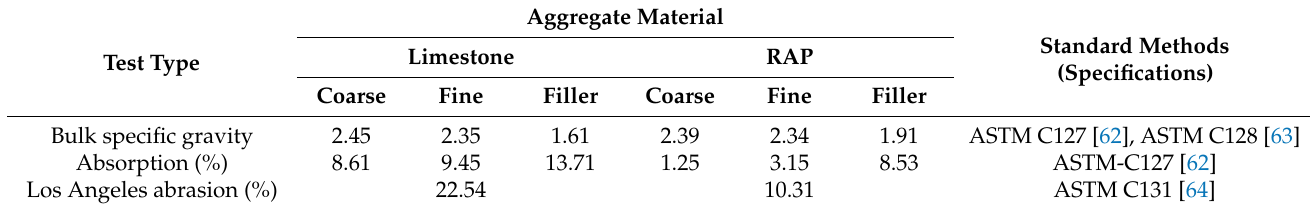
Table 2. Technical properties of the virgin asphalt cement.